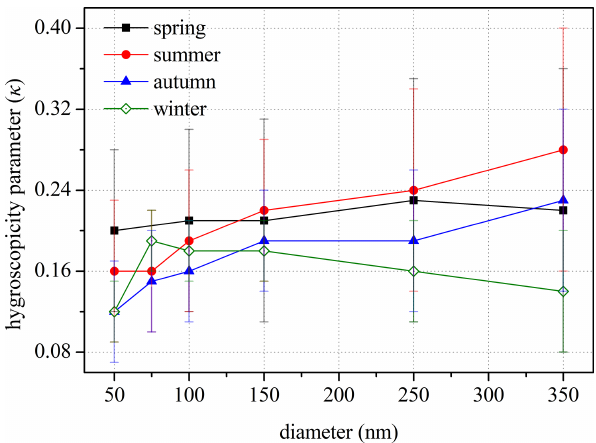
Figure 1. Change in average κ with aerosol diameter at the PKU site in four different seasons between May 2014 and January 2015 (Wang et al.,